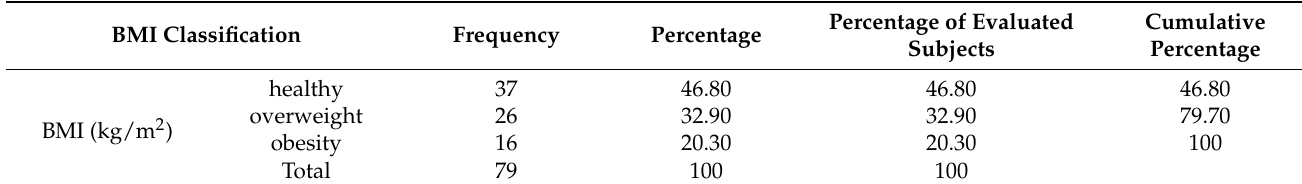
Table 10. Distribution of body mass indices at the final testing.